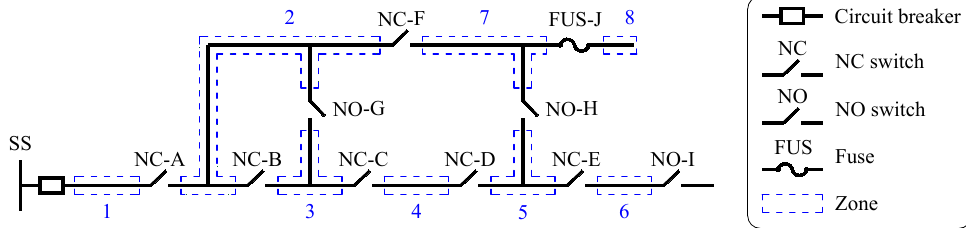
Figure 3. Feeder used as example to derive the model of the network.